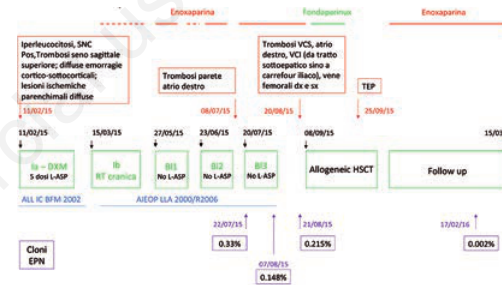
Figura 1. Caso di LLA-T HR: